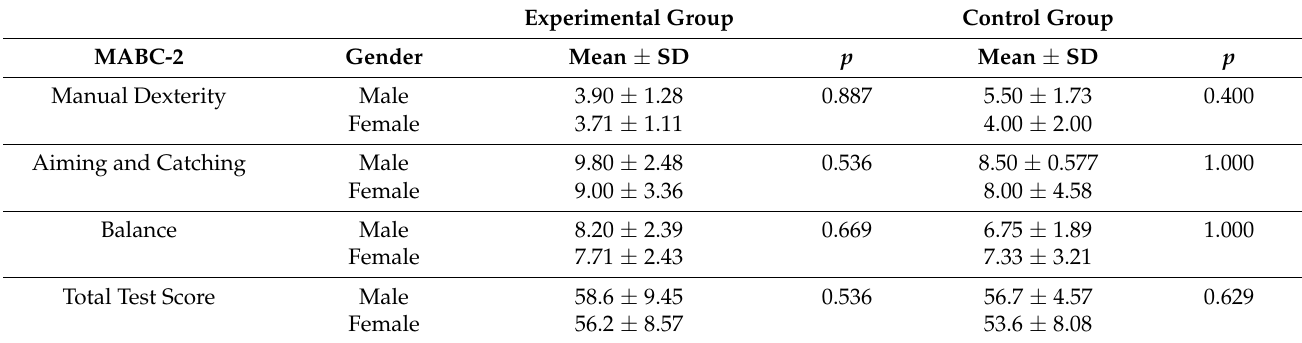
Table 6. Pre-intervention. Gender effect in each group at MABC-2 domains.